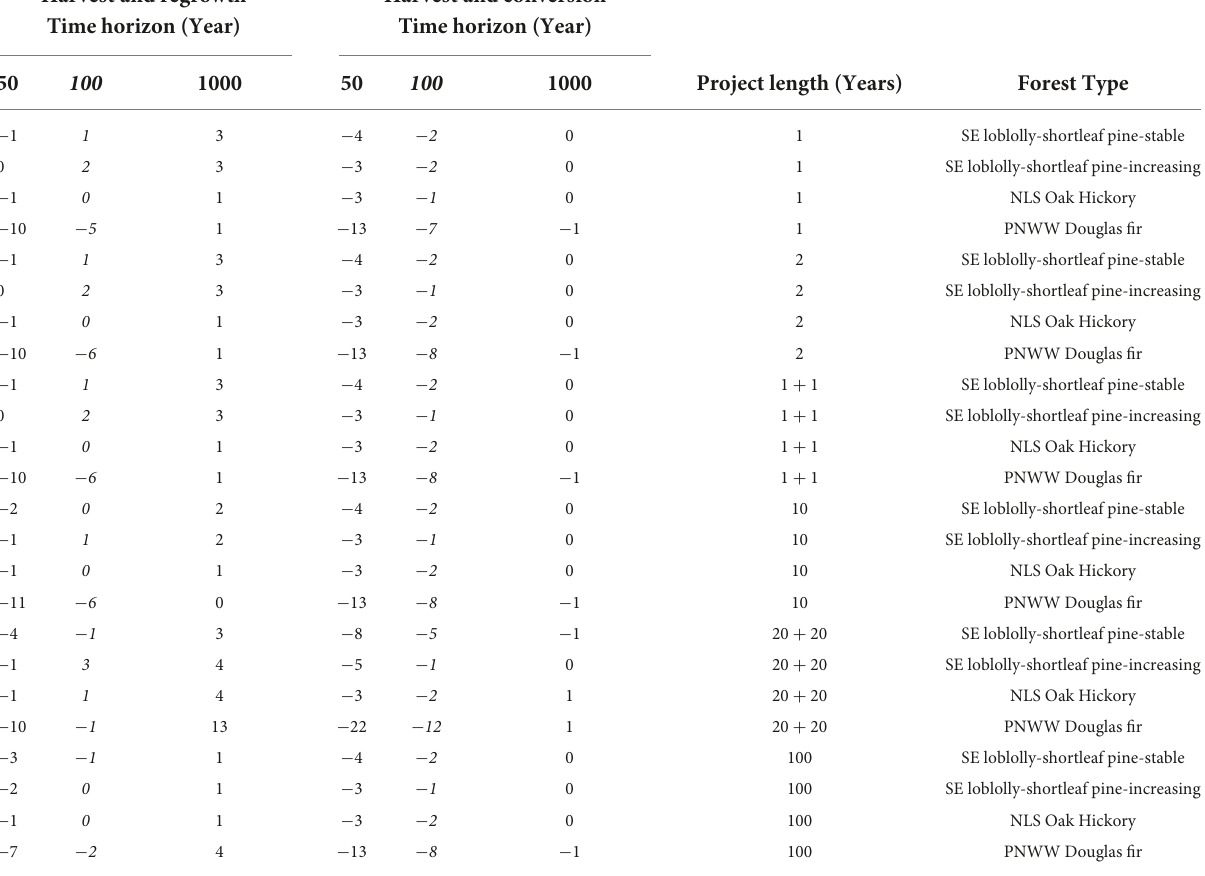
TABLE 2 Sensitivity analysis for ton-year accounting, showing values of average annual net carbon flux (tC/ha) varying by time horizon. Harvest and